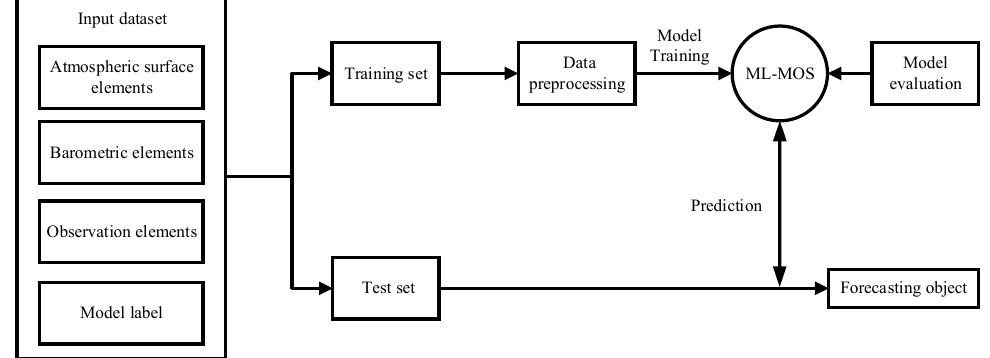
Figure 6. ML-MOS model data processing and training flowchart.